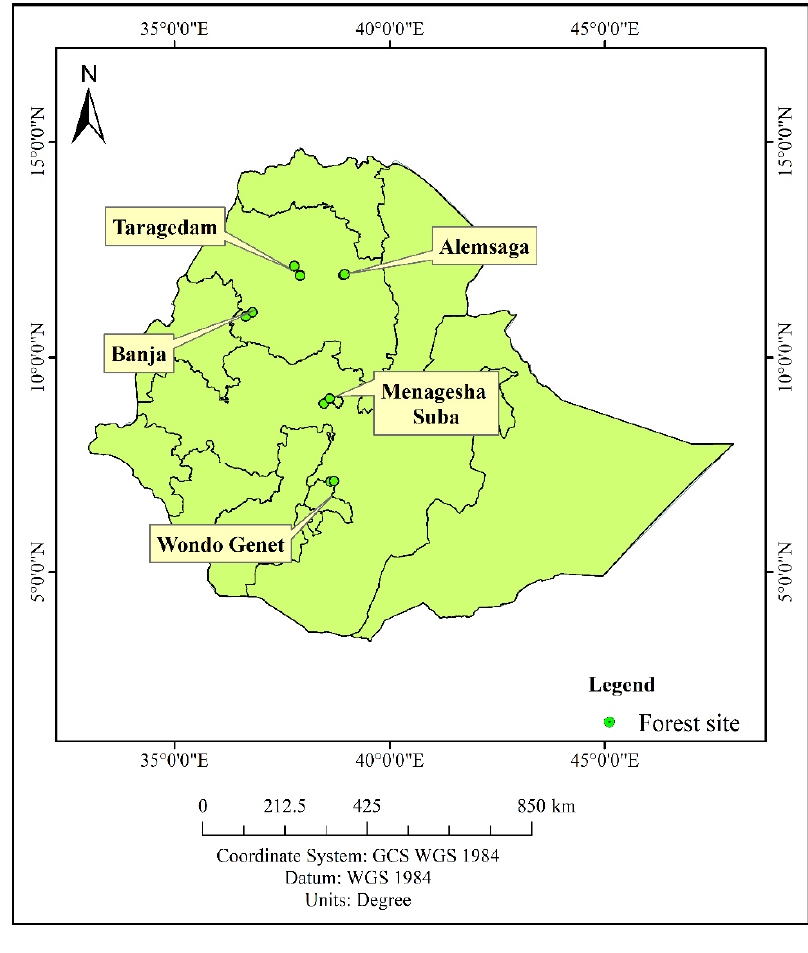
Figure 1. Map showing the locations of forests in which the study plots were located.